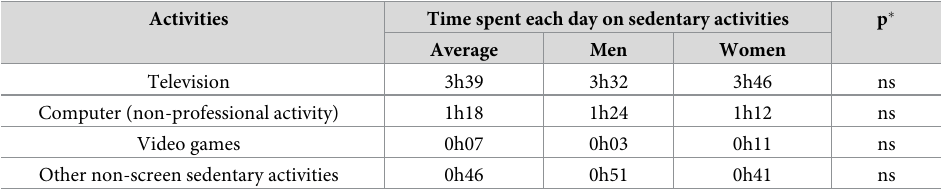
Table 6. Time spent each day on sedentary activities by gender.